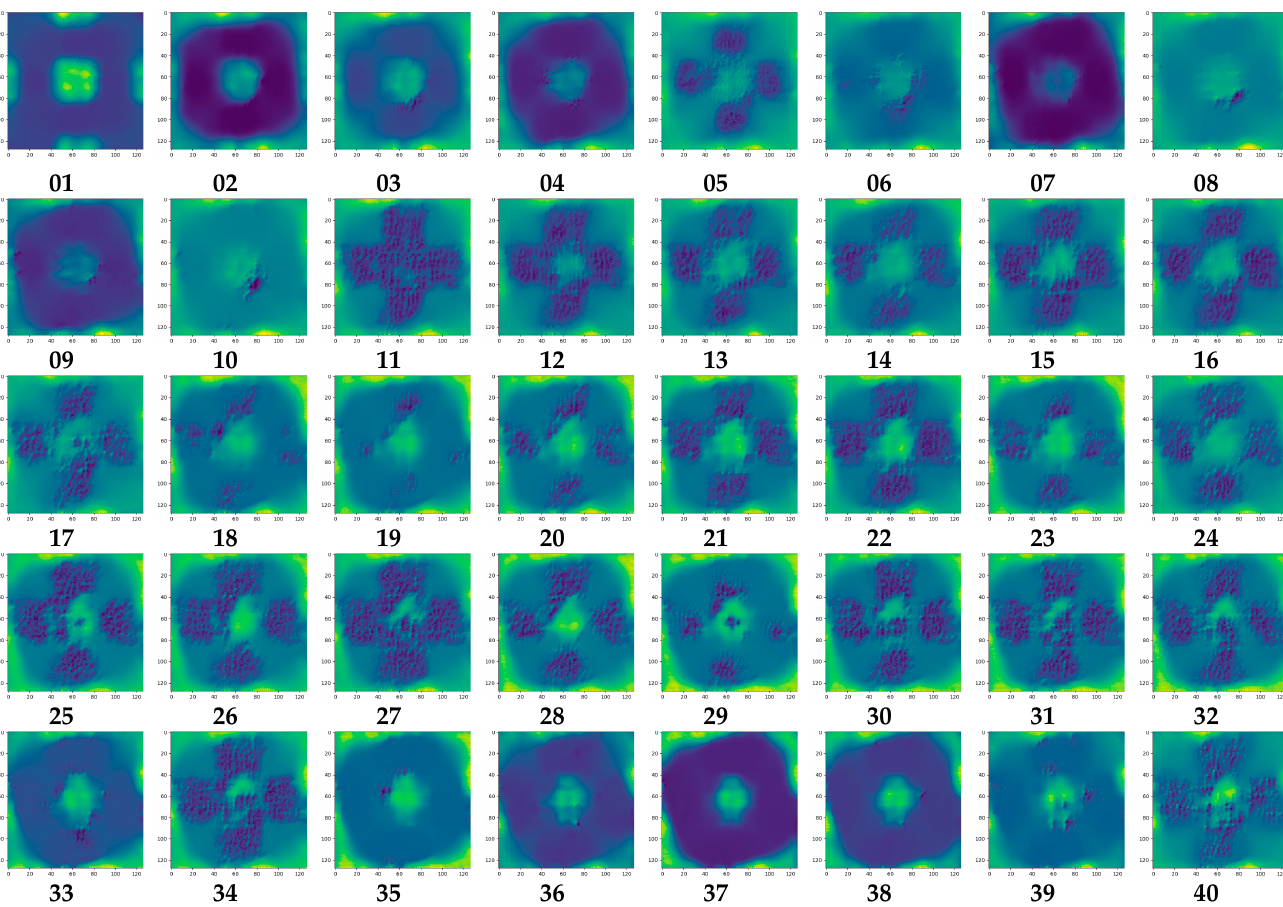
Figure 6. Feature maps for each epoch of the category c (‘light band’) of the classi fi er. The numbers below images represent the current epoch. below images represent the current